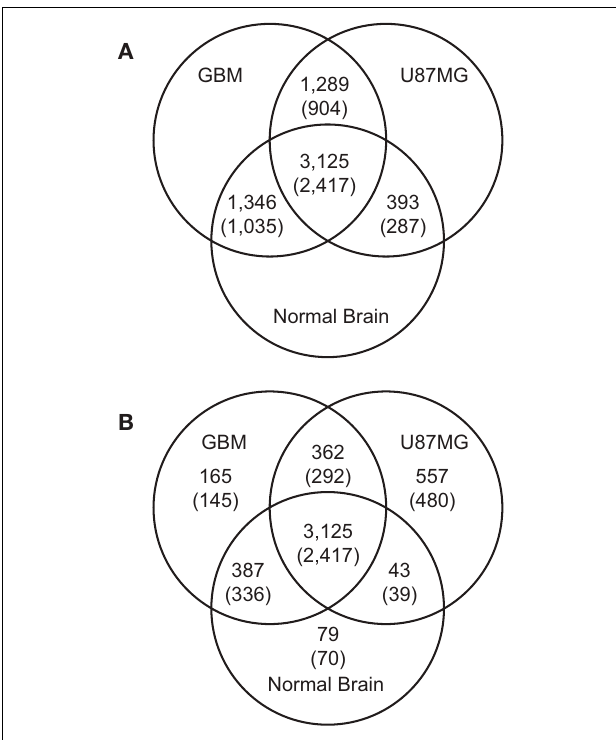
FIGURE 6 | Comparison of methylation between U87MG, and GBM DNA samples. (A) Estimation of methylated fragments in all samples determined by using p ≤ 0.001 for each sample identifi es 3,125 fragments (covering 2,417 CpG Islands). 4,414 fragments (3,321 CpG Islands) were common to both GBM and U87MG, 4,471 fragments (3,452 CpG Islands) common to both GBM and normal, and 3,518 fragments (2,704 CpG Islands) common to both normal and U87MG. (B) Estimation of uniquely methylated fragments using methylation determination based on p ≤ 0.001 and unmethylated determination based on p > 0.01. Fragments within the intermediate region with 0.001 ≤ p ≤ 0.01 are not